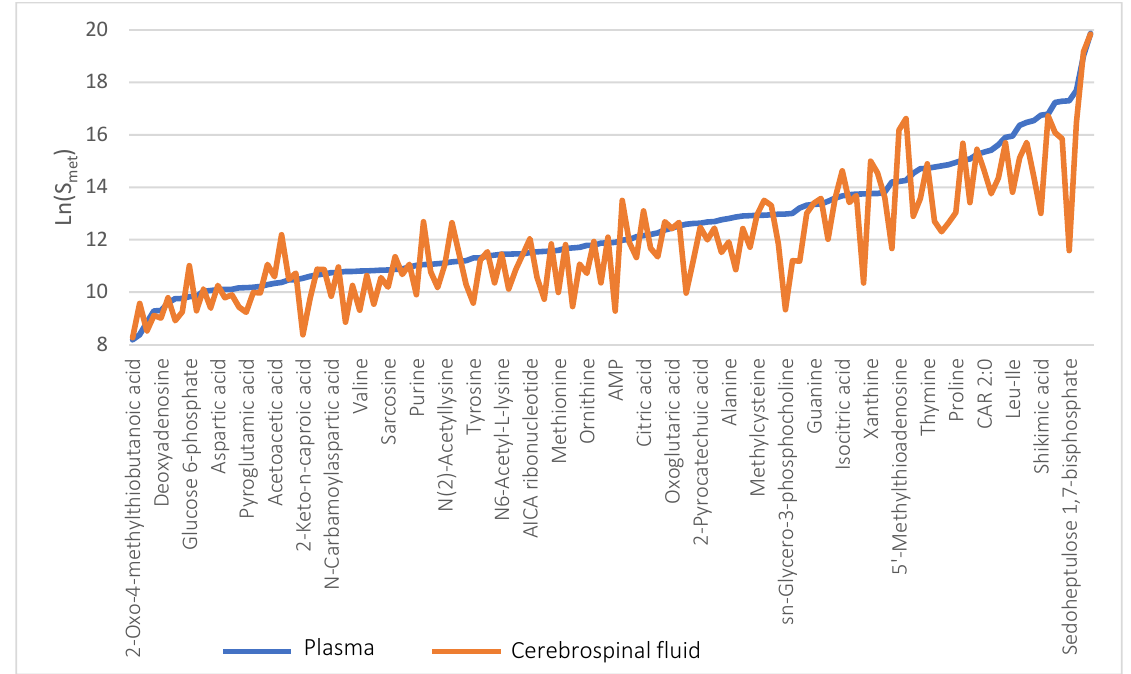
Figure 3. Metabolic profiles of blood plasma (blue line) and CSF (orange line) of the combined group of glioma patients and control group. Metabolites are ranged according to their increasing plasma content. Ln values of the average peak area of a metabolite are shown on the Y axis.